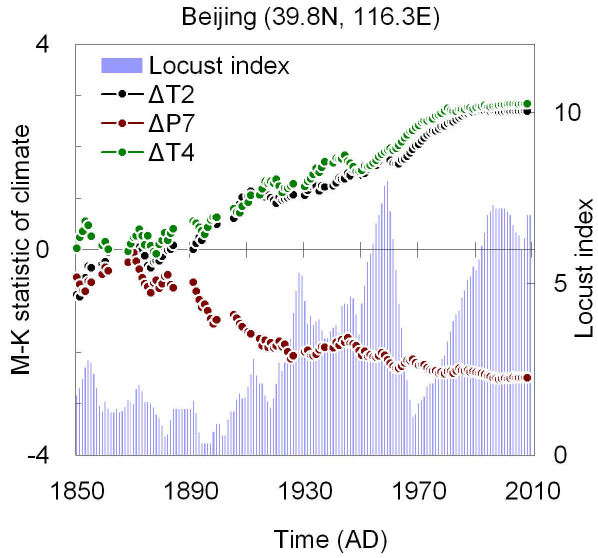
Fig. 5. Comparisons of locust outbreaks with trends of climate changes in Beijing by using Mann–Kendall trend test ( p < 0 . 05). P7, T2 and T4 represent July precipitation, February and April tem- peratures